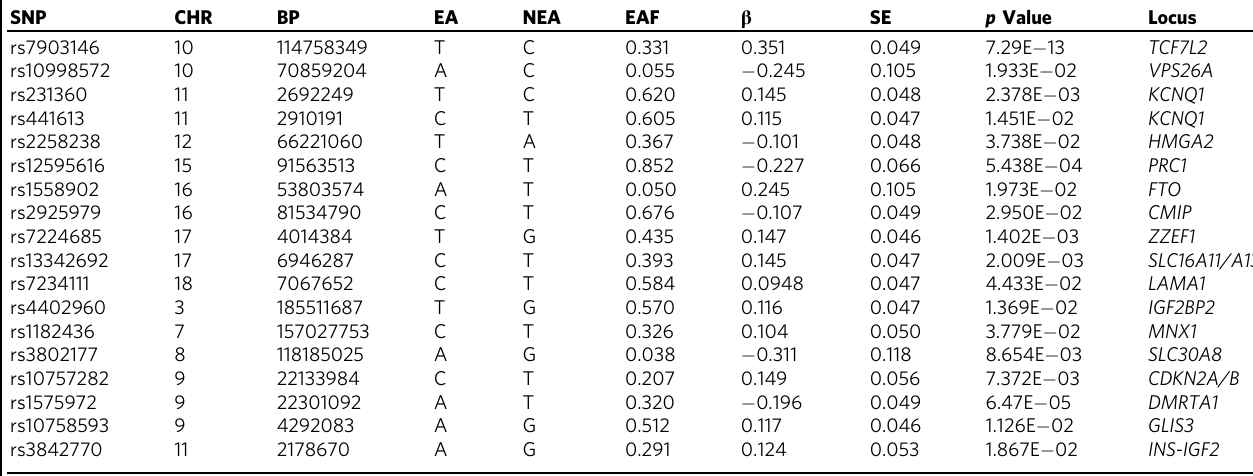
Table 3 Exact replication of established T2D loci in 5231 sub-Saharan